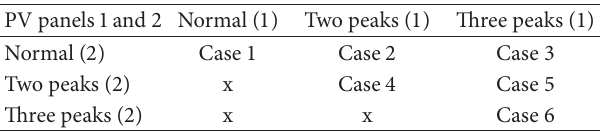
Table 5: PSO simulation conditions for the distributed two-panel PV